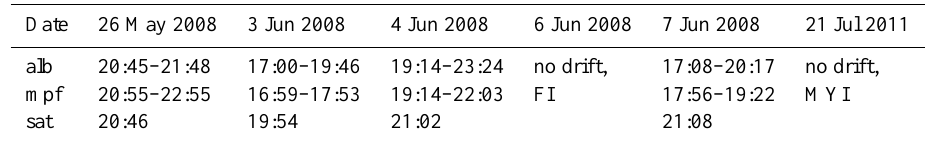
Table 4. UTC time of aerial measurements (mpf and alb) and satellite overflights (sat) for each day of available aerial measurements of MELTEX 2008 and NOGRAM 2011. Cases with large time difference (greater than 1.5h) between satellite and field measurements are shown in red.